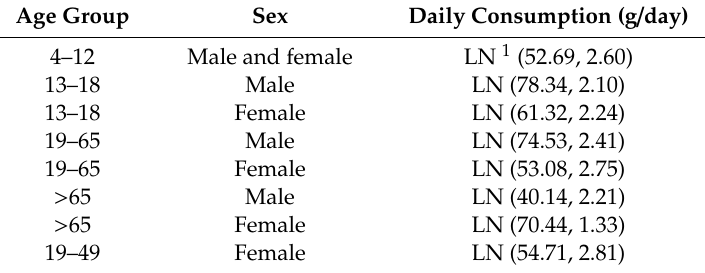
Table 1. Distribution of the daily consumption rate of beef for each sex and age